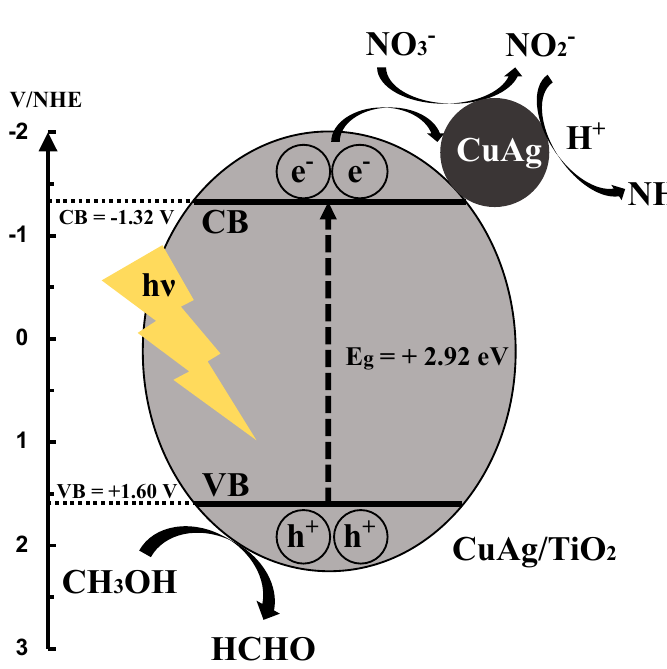
S1: Summary of TiO 2 samples, Figure S1: XRD spectra of (a) TiO 2 , (b) Cu / TiO 2 , (c) Ag / TiO 2 , (d) Cu 0.5 Ag / TiO 2 , (e) Cu 0.9 Ag / TiO 2 , (f) Cu 1.5 Ag / TiO 2 , (g) 0.5 wt% Cu 0.9 Ag / TiO 2 , and (h) 1.5 wt% Cu 0.9 Ag / TiO 2 ., Figure S2: TiO 2 samples, Figure S1: XRD spectra of (a) TiO 2 , (b) Cu/TiO 2 , (c) Ag/TiO 2 , (d) Cu 0.5 Ag/TiO 2 , (e) Cu 0.9 Ag/TiO 2 , (f)